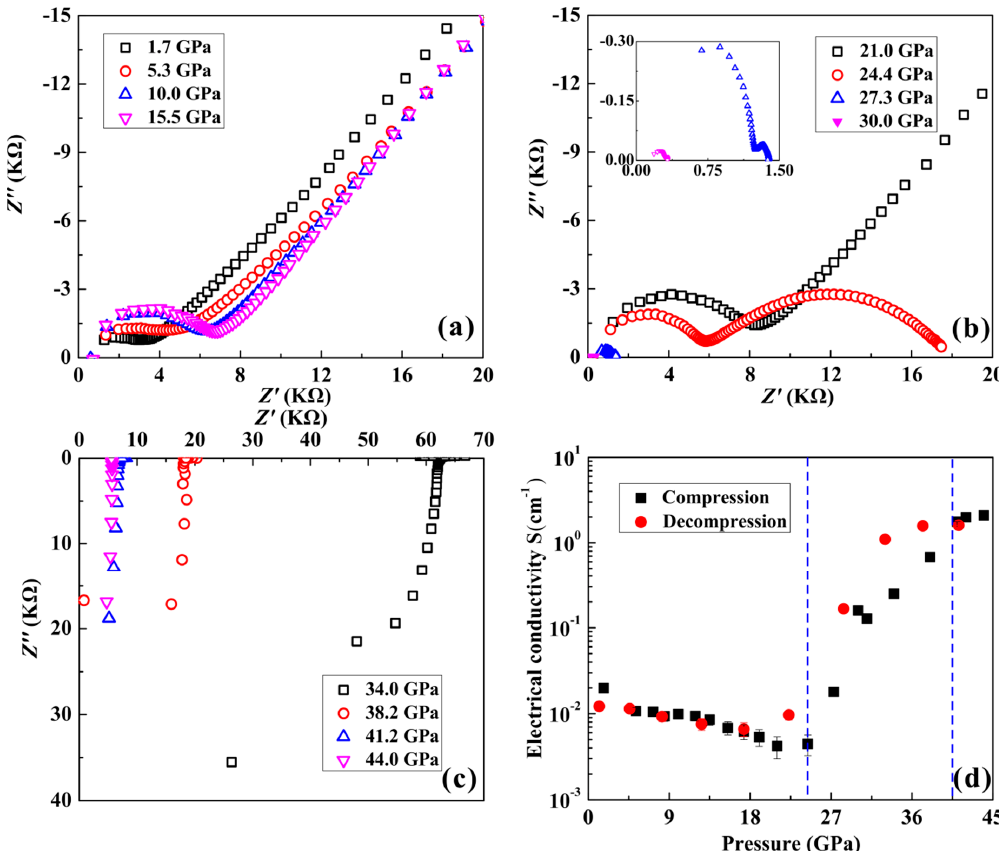
Figure 5. The electrical behaviors for orpiment with increasing pressure. ( a – c ) The complex impedance spectra of orpiment at selected pressures. ( d ) The variations of electrical conductivity for orpiment with the increasing pressure and decreasing pressure.